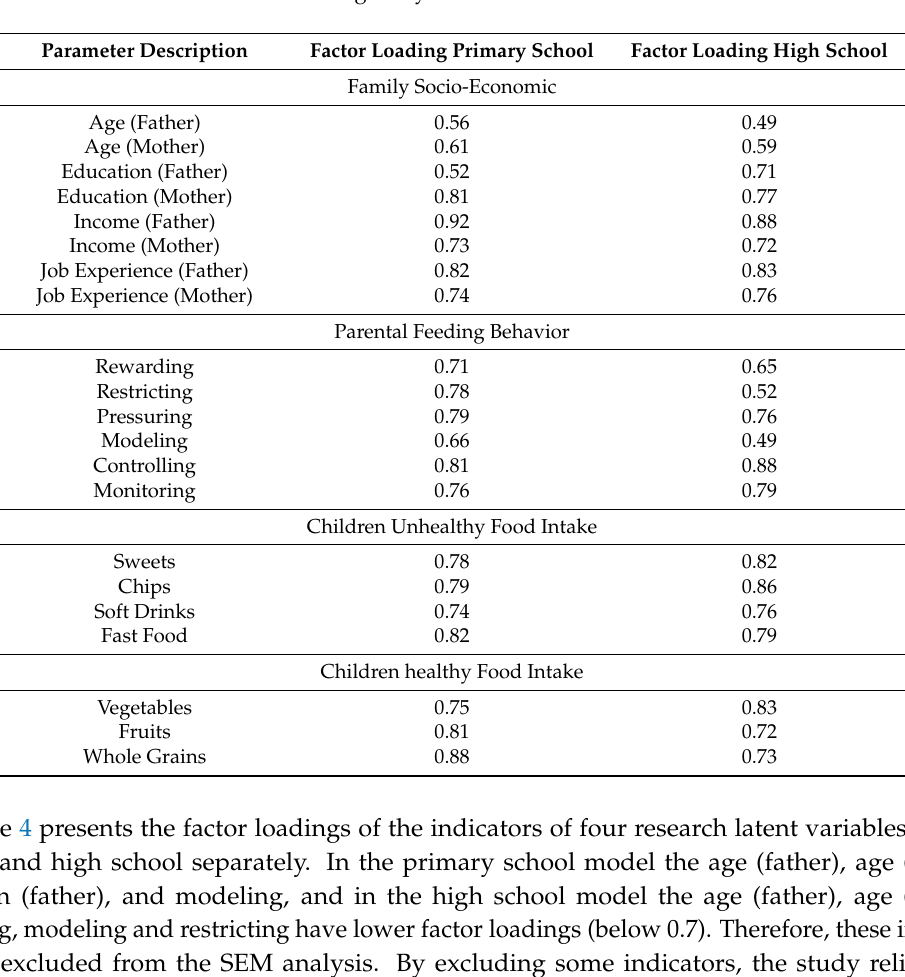
Table 4. Factor loading analysis of the research latent variables.